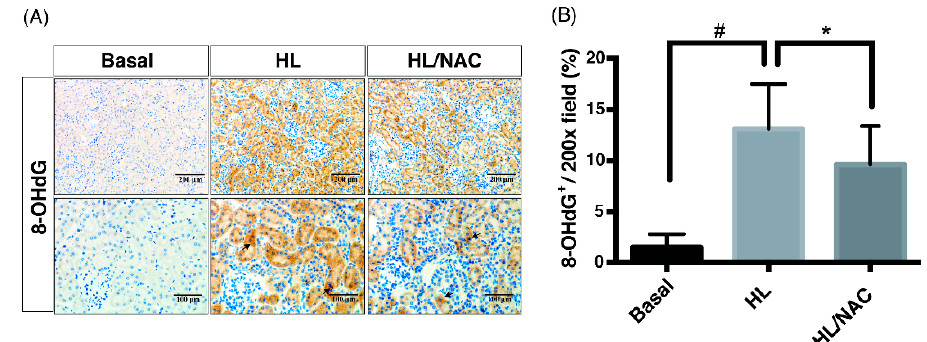
Figure 4. Scavengers of non-specific ROS attenuate oxidative injury in obese kidney fibrosis with metabolic endotoxemia. ( A ) Immunohistochemical staining methods were used to detect expressions of 8-OHdG. The HL group (HF mice with ME) exerts the highest expression of 8-OHdG, which was ameliorated by NAC. Scale bars are 200 µ m or 100 µ m in the panels. ( B ) Quantification analysis was performed by imageJ software. Data are expressed as mean ± SD ( n = 8); * p < 0.05, # p < 0.01, to compare the differences between the two indicated groups.